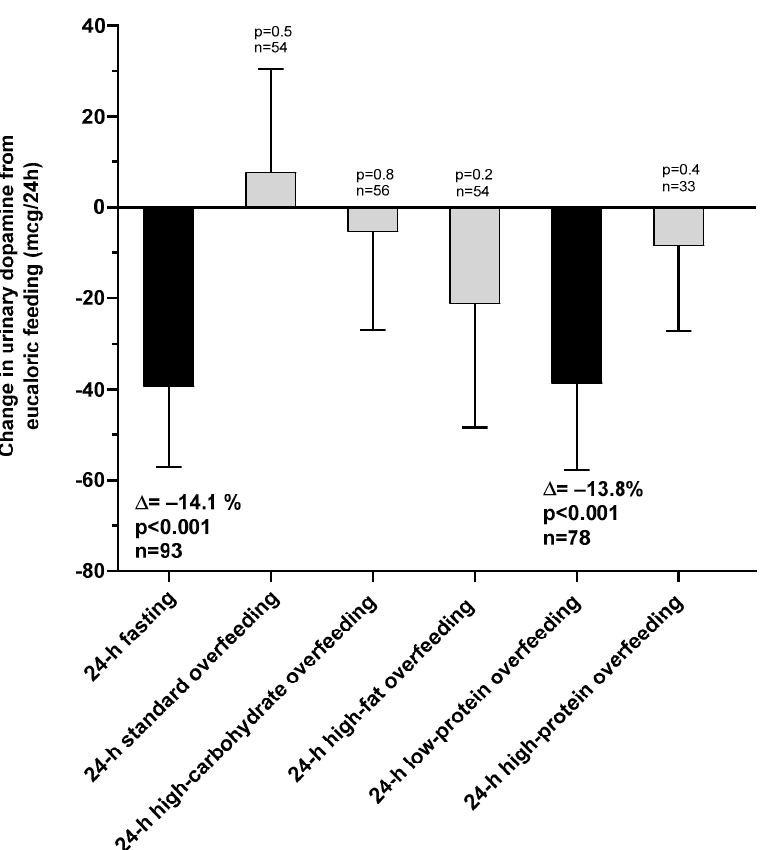
Figure 3. Changes in urinary dopamine excretion rate during 24-h fasting and different overfeeding diets as compared to 24-h energy balance conditions. Error bars represent 95% CI of the mean difference.